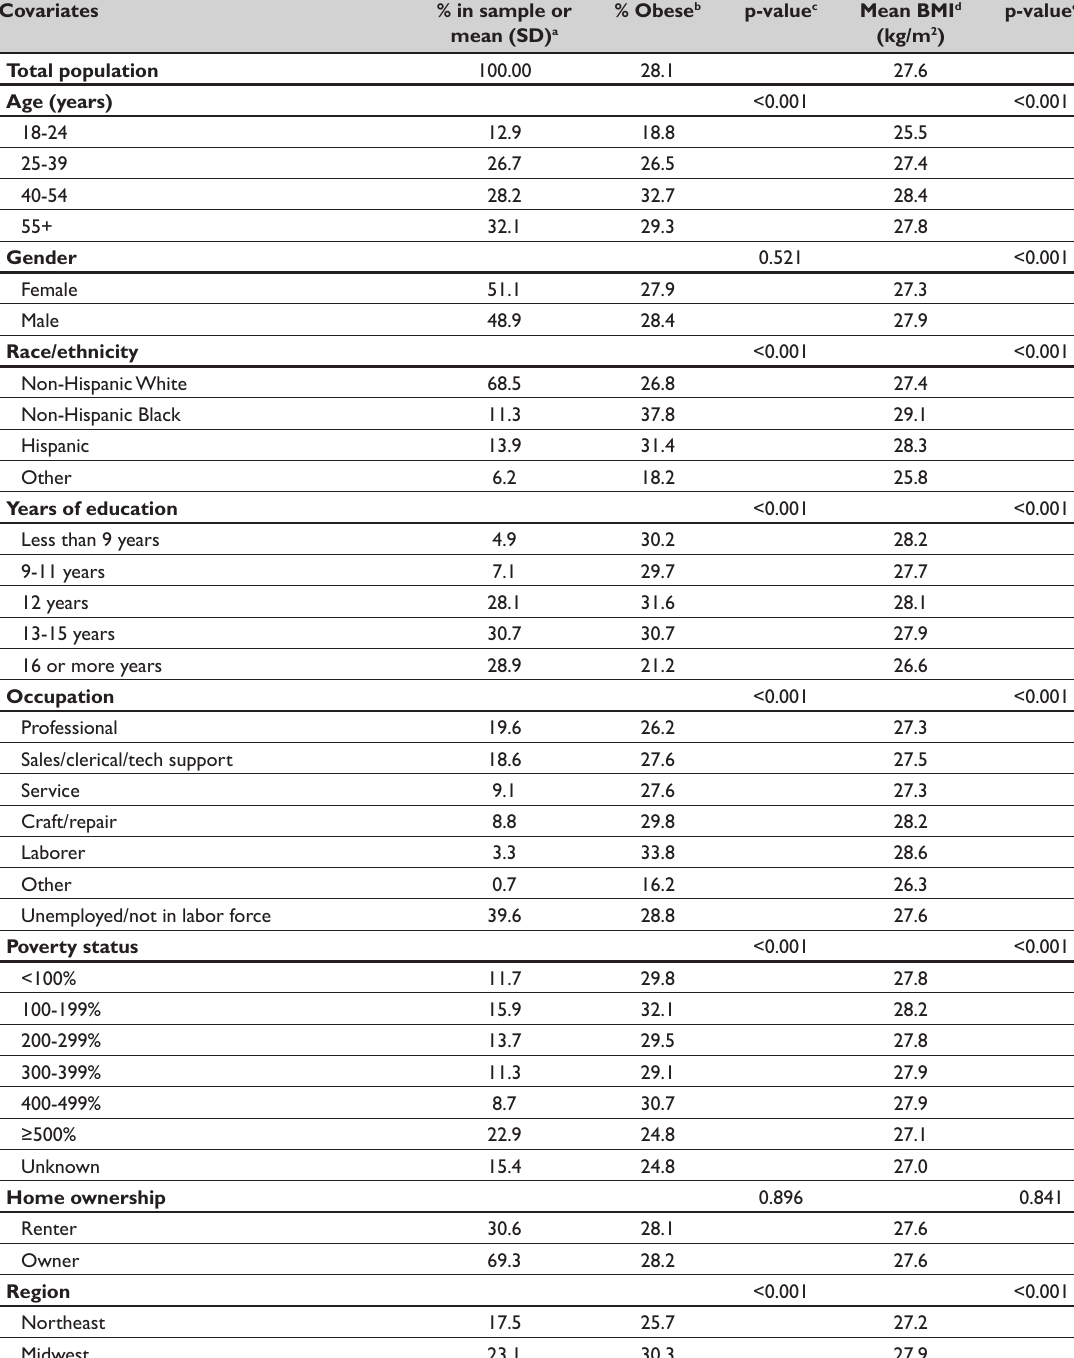
Table 1. Weighted Sample Characteristics, Percent Obese and Mean BMI